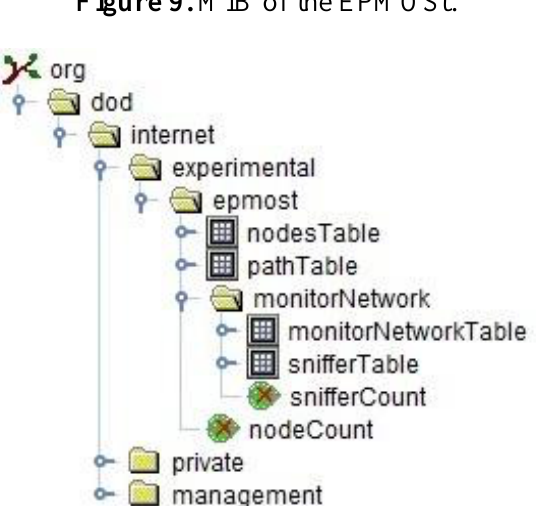
Figure 9. MIB of the EPMOSt.